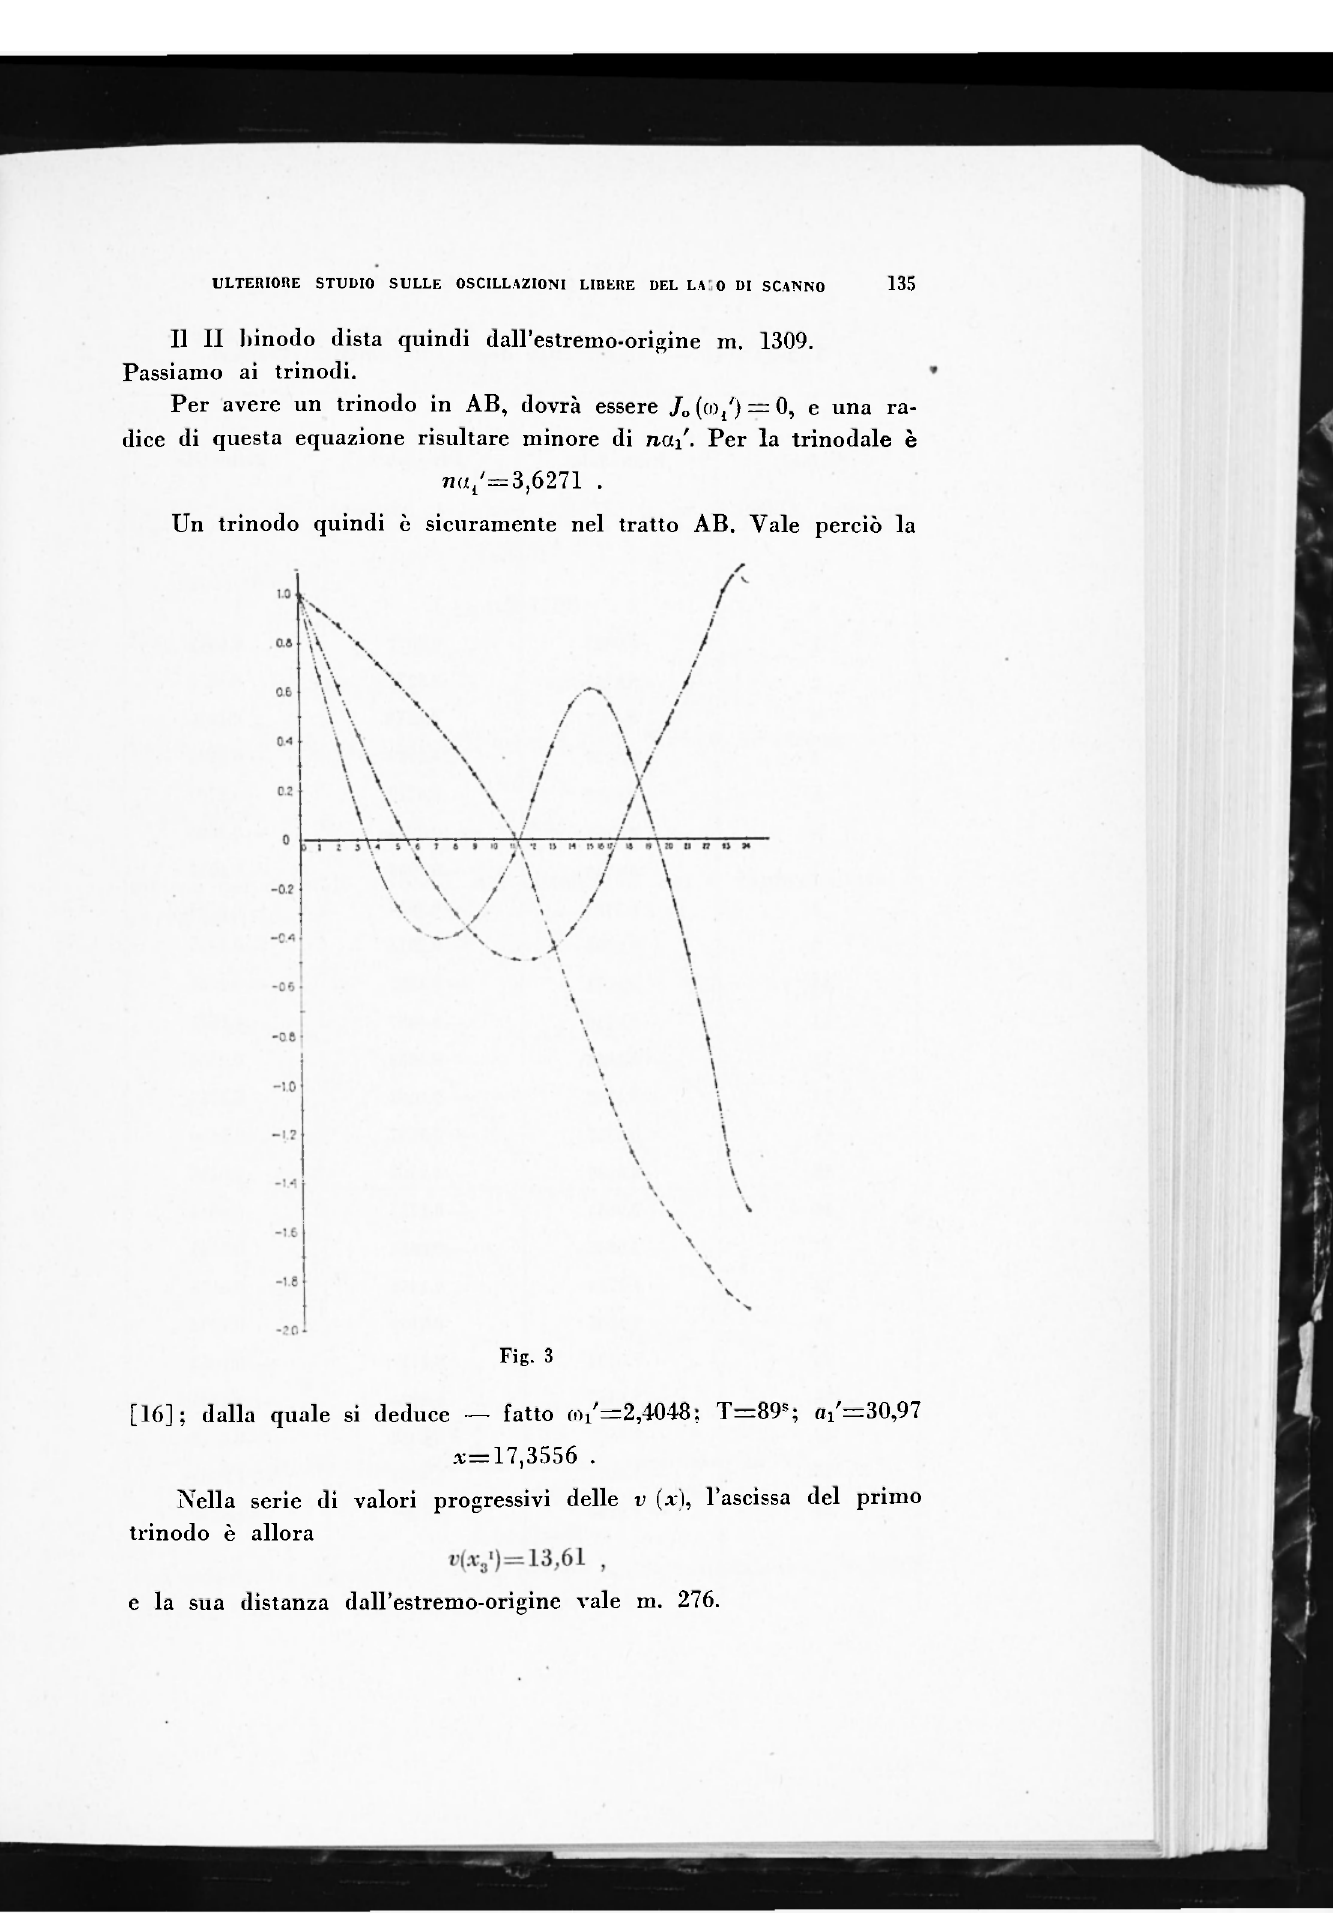
[16]; dalla quale si deduce — fatto toi'=2,4048; T=89 s ; a/=30,97 .\= 17,3556